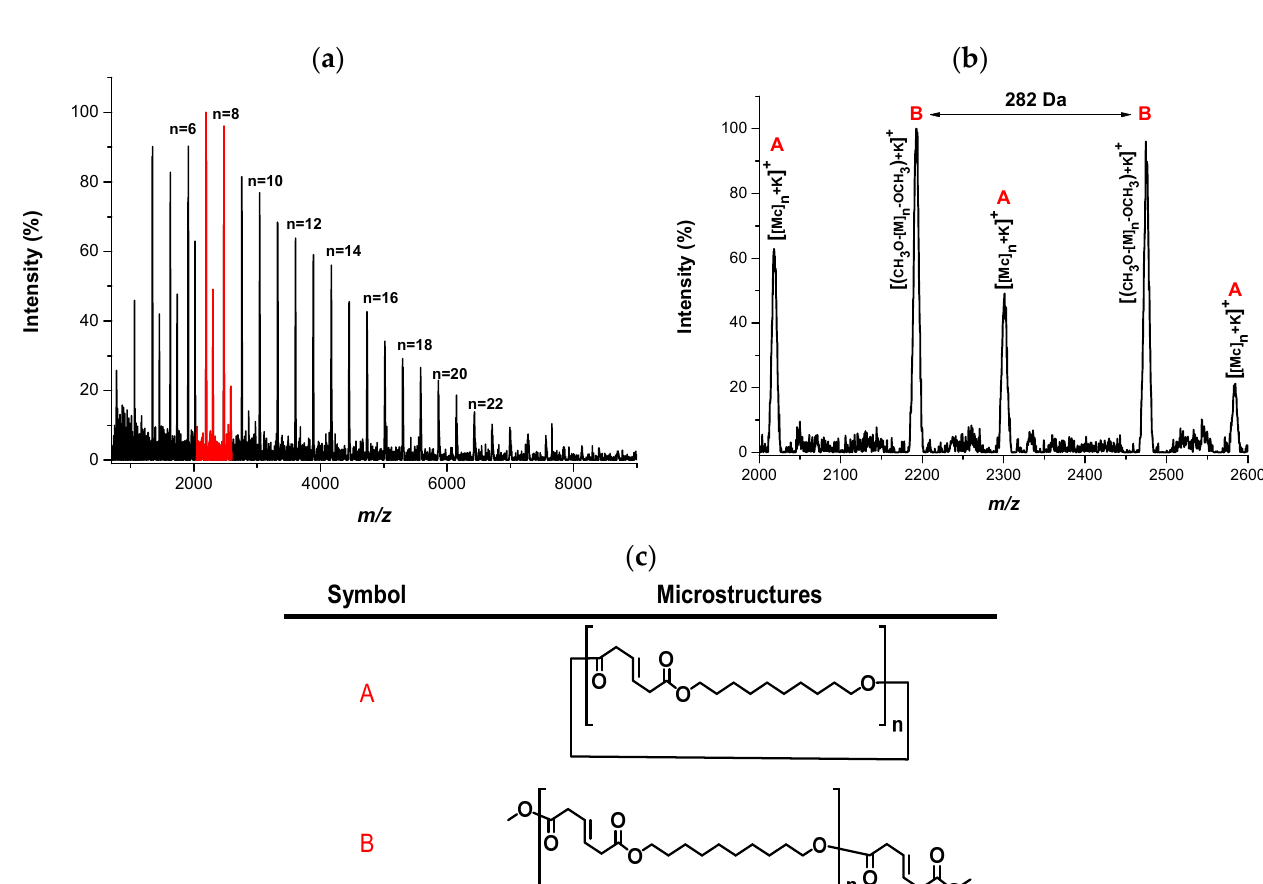
Figure 2. ( a ) MALDI-ToF MS spectrum of the TBHM-based polyester (entry 9 in Table 1) produced via enzymatic polymer- ization, ( b ) magnified part with detailed peak interpretation, and ( c ) microstructures of the obtained oligoester.